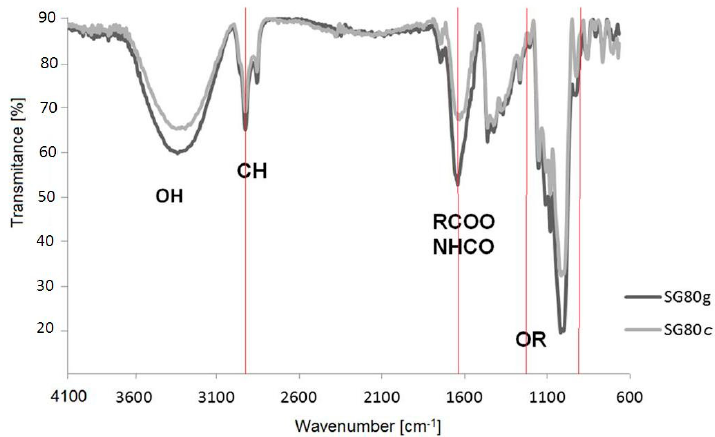
Figure 5. FTIR spectra of cellulose-starch composites.